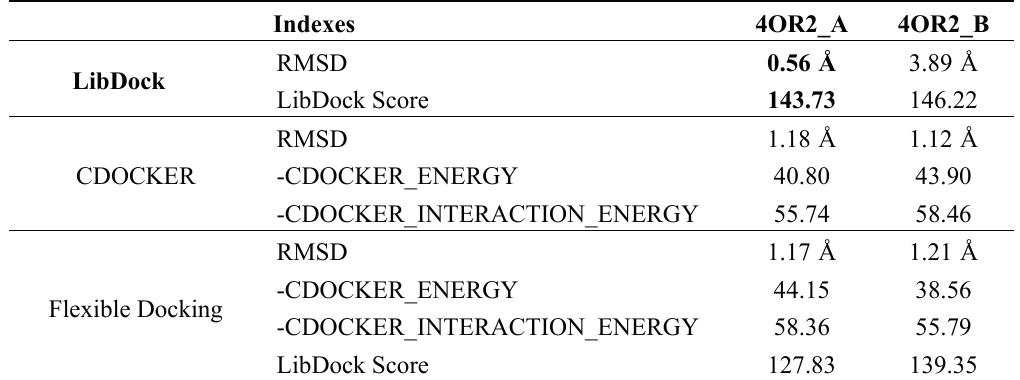
Figure 3. The comparison between the initial binding pose interactions and the docked pose interactions of FITM in crystal structure 4OR2_A. ( A ) The pose of FITM initially binding to 4OR2_A was compared with that of the one predicted by molecular docking (yellow); ( B ) The initial binding pose interactions in the allosteric binding site; ( C ) The docked pose interactions. Table 2. The corresponding score and RMSD value of FITM with three docking